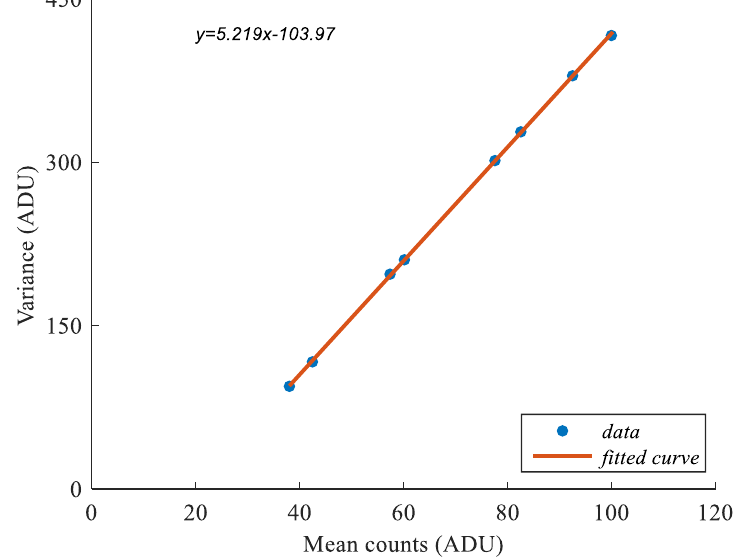
Figure 3. Variance versus mean linear relation for several images extracted by the MT9J001 with the laser beam switched on.